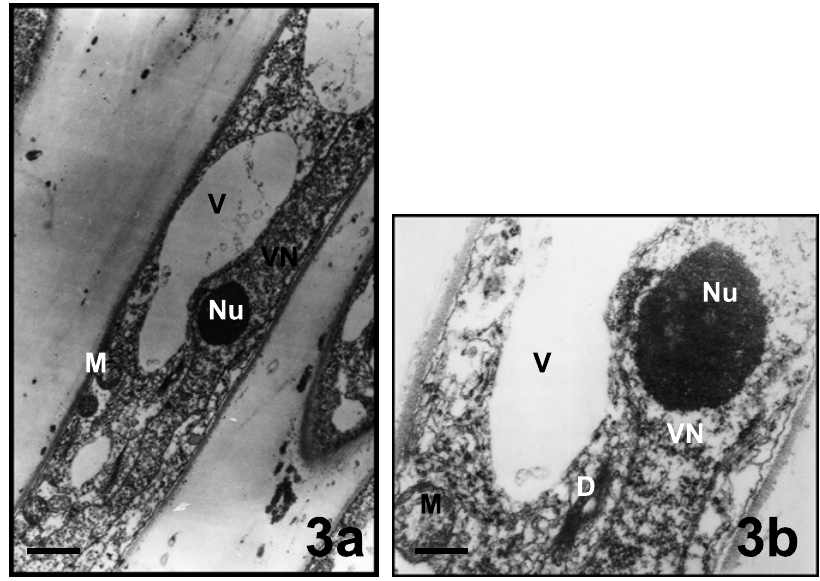
Fig. 3 – Nuclear zones (vegetative) of pollen tubes in Mimulus aurantiacus . a, bar = 1 μ m; b, bar = 100 nm. (D, dictyosome; M, mitochondria; Nu, nucleolus; V, vacuol VN, vegetative nucleus).